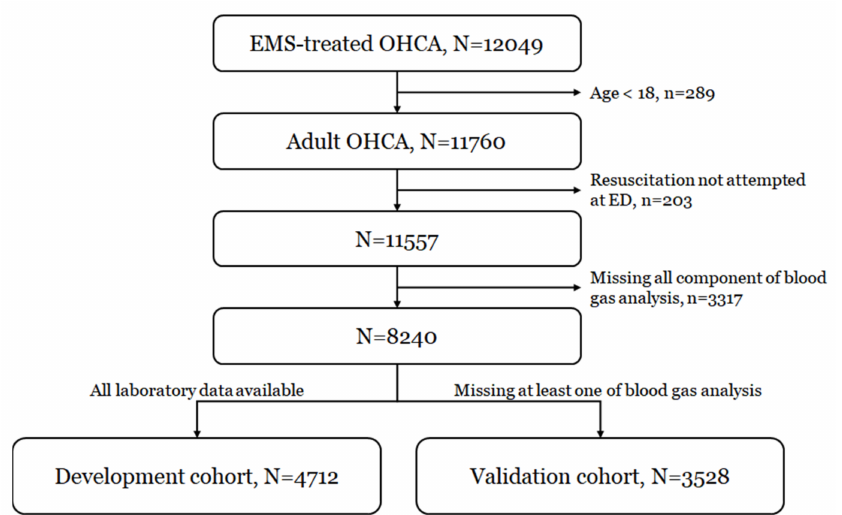
Figure 1. Study flow chart of the development and validation cohorts. OHCA: out-of-hospital cardiac arrest, EMS: emergency medical services, ED: emergency